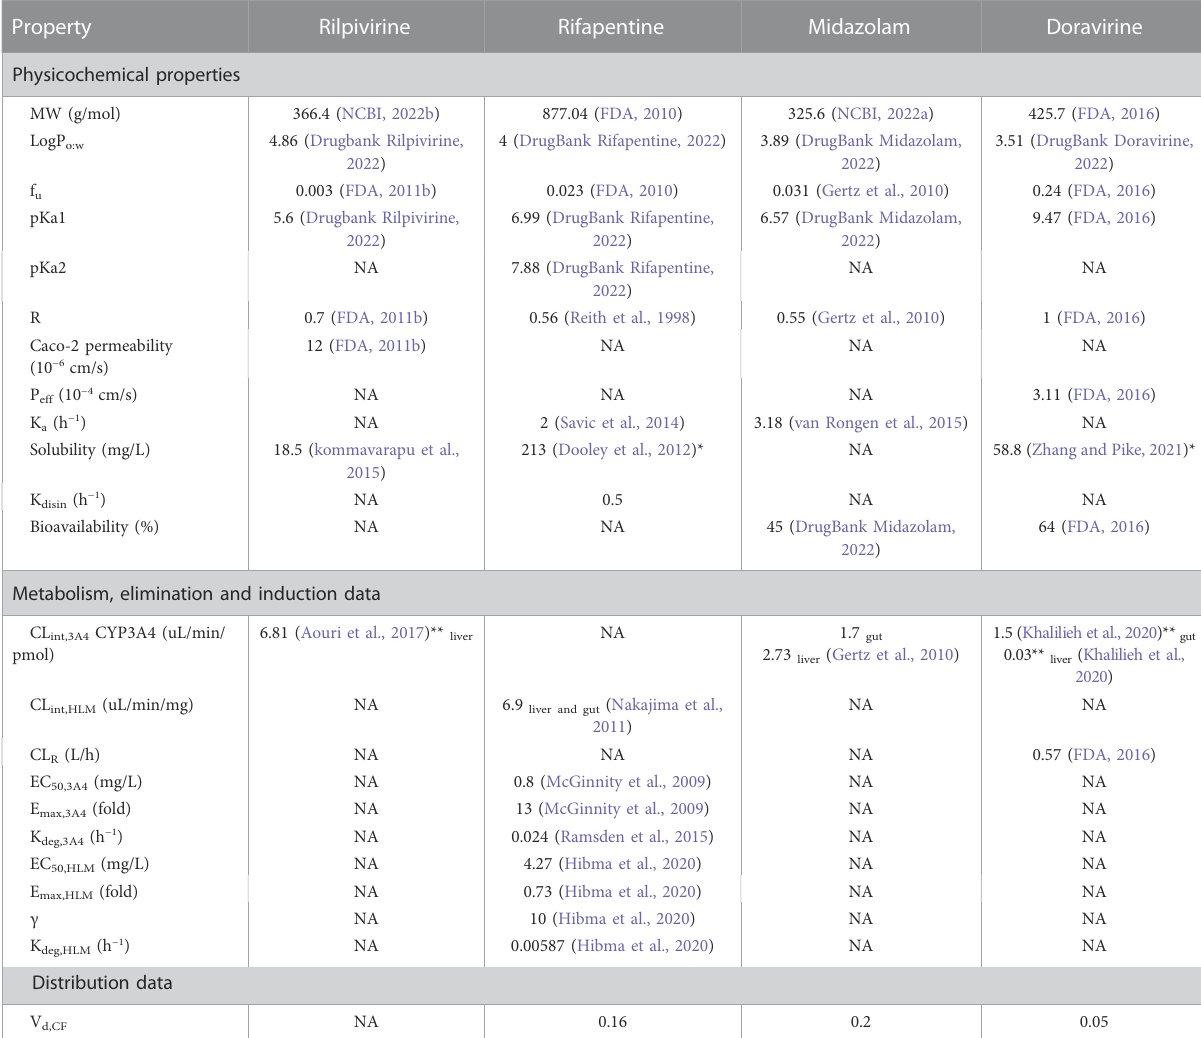
TABLE 1 Summary of physicochemical and in vitro data for rilpivirine, rifapentine, midazolam and